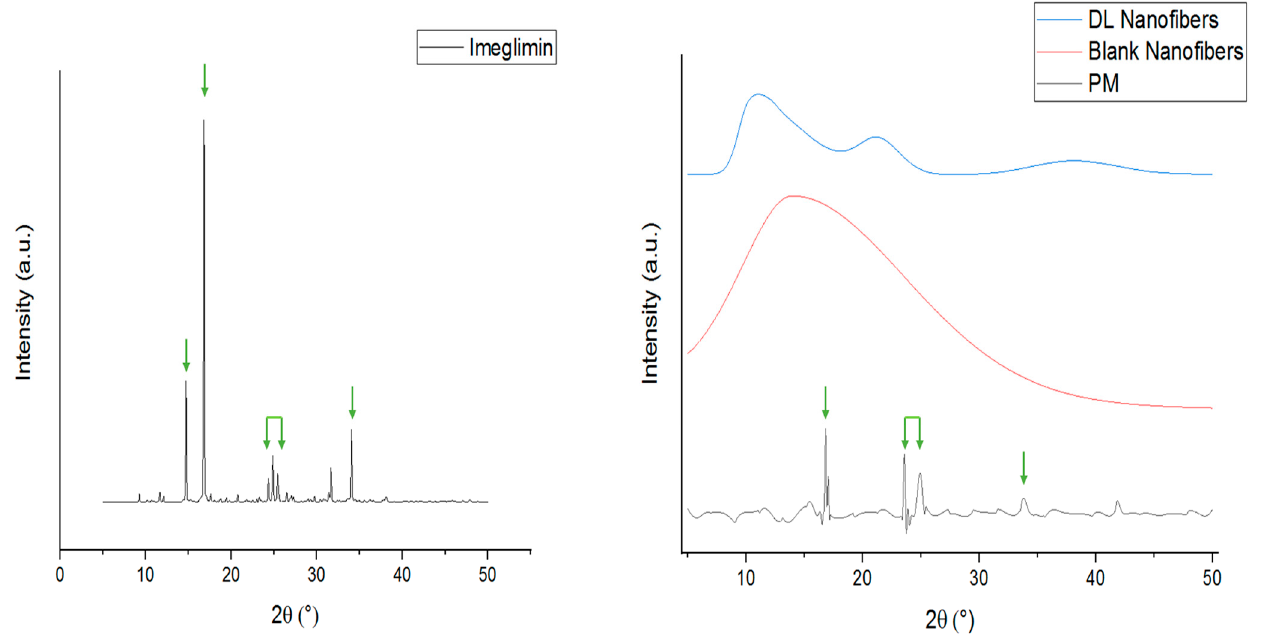
Figure 2. XRD pa tt erns of imeglimin, PM, blank, and imeglimin-loaded nano fi bers showing that Figure 2. XRD patterns of imeglimin, PM, blank, and imeglimin-loaded nanofibers showing that imeglimin was in the crystalline form (presence of characteristic re fl ections at 2 θ : 14.71°, 16.82°, imeglimin was in the crystalline form (presence of characteristic reflections at 2 θ : 14.71 ◦ , 16.82 ◦ , 24.36°, 24.87°, 25.42°, 31.64°, and 34.03°, which are re fl ected by the green arrows) as pure and in the 24.36 ◦ , 24.87 ◦ , 25.42 ◦ , 31.64 ◦ , and 34.03 ◦ , which are reflected by the green arrows) as pure and in the PM. The blank and drug-loaded nano fi bers were amorphous (broad halo pa tt ern). The absence of PM. The blank and drug-loaded nanofibers were amorphous (broad halo pattern). The absence of the imeglimin distinct peaks in the drug-loaded nano fi bers suggests the molecular dispersion of the the imeglimin distinct peaks in the drug-loaded nanofibers suggests the molecular dispersion of the drug due to the electrospinning process. DL: drug-loaded, PM: physical mixture. drug due to the electrospinning process. DL: drug-loaded, PM: physical